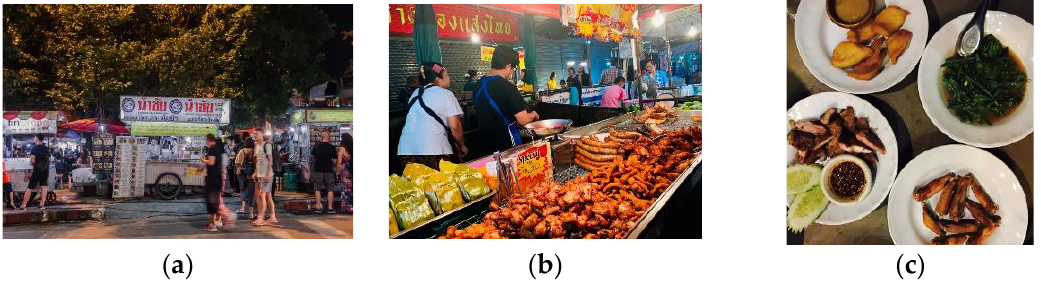
Figure 5. Images of local Thai foodscape: ( a ) the street vendors; ( b ) locals sell and buy fried meat; ( c ) some favorable local dishes adaptable to the taste of Chinese tourists.